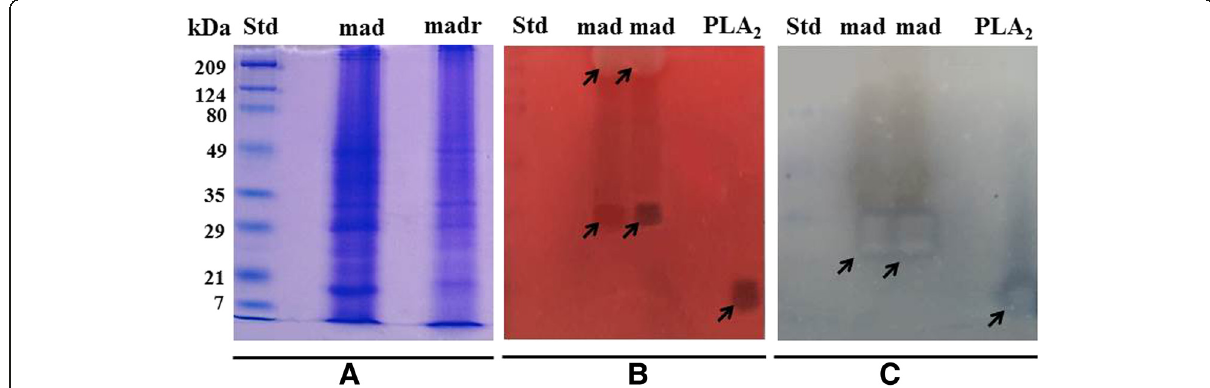
Fig. 4 a Electrophoretic profile under non-reducing (Mad) and reducing (Madr) conditions. The protein bands were visualized by the Coomassie blue staining method. b Hemolysis zymogram on a 1.5 % agar gel supplemented with 5 % egg yolk and 3 % of washed erythrocytes, two hemolytic zones were observed in the gel corresponding to ~28-30 and ~200 kDa. c PLA 2 zymogram on a 2 % agarose gel supplemented